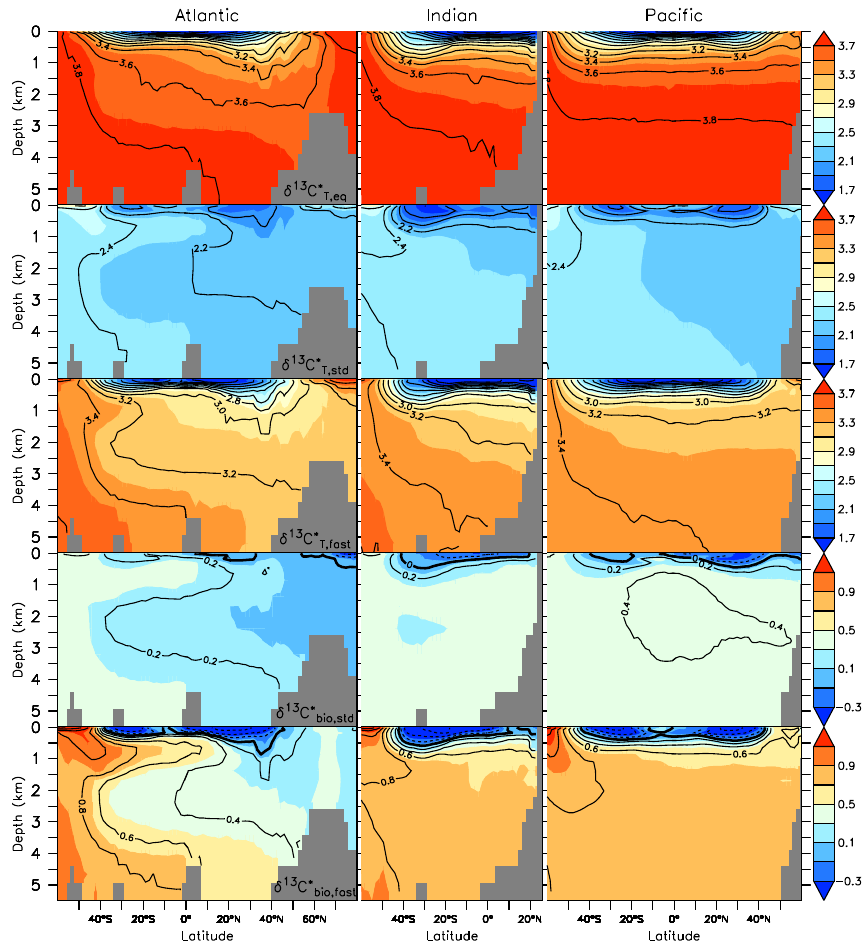
∗ 13 C ∗ 13 C ∗ 13 C ∗ (global surface mean T, eq ; δ T, std ; δ T, fast ; δ bio , std